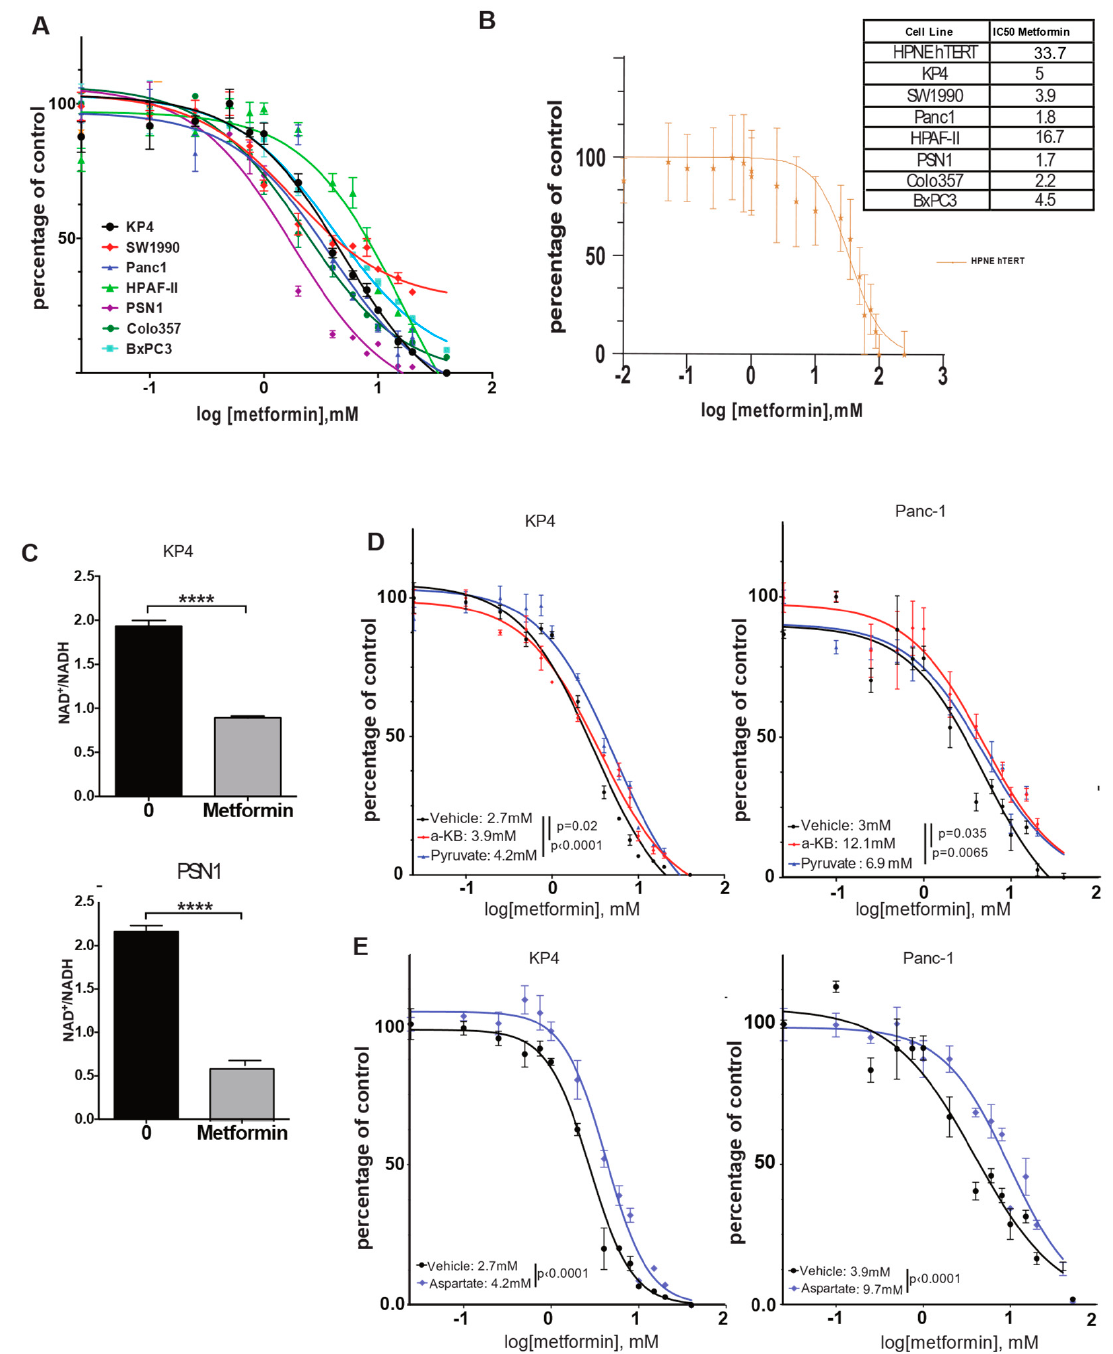
Figure 1. Metformin decreases growth of PDAC cells through a reduction in NAD + /NADH intra- cellular ratio in vitro. ( A , B ) Dose-response curves and IC50s of metformin on a panel of human PDAC cells ( A ) or HPNE cells ( B ) over 3 days of growth. Values are means of triplicates ± SEM. ( C ) Quantification of NAD + /NADH ratio in KP4 and PSN1 PDAC cell lines treated with 10 mM metformin or vehicle for 6 h. Values are means of triplicates ± SEM, **** p -value ≤ 0.0001 (Student’s t -test). ( D , E ) Dose-response curves and IC50s of metformin when PANC-1 and KP4 cells are on 4 mM α -ketobutyrate ( α -KB), 1 mM of pyruvate ( D ), or 20 mM of aspartate ( E ) over 3 days of growth. Values are means of triplicates ± SEM. For all experiments, n =